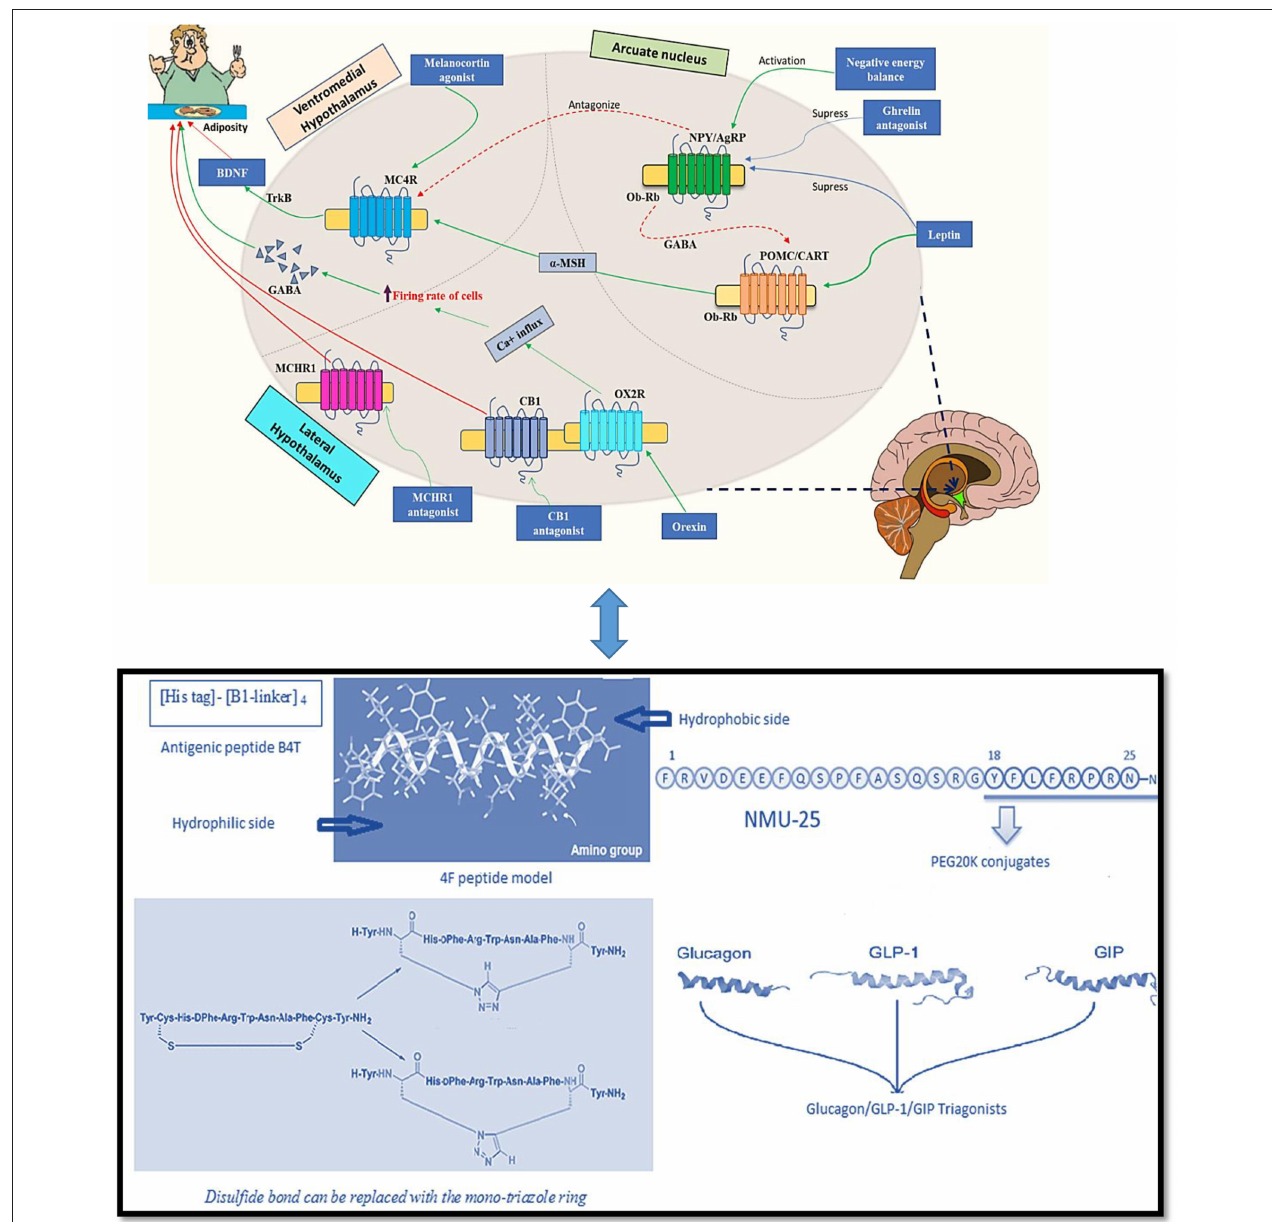
FIGURE 1 | Endogenous peptides and peptidomimetics approaches for treating obesity [Adapted from Navab et al. (9), Tschop et al. (10), and Inooka et al. (11); Kim et al. (12); Tala et al. (13)] ( Indications- Green solid arrow-activation, blue solid arrow-suppression, red dashed arrow-antagonism, and red solid arrow-block